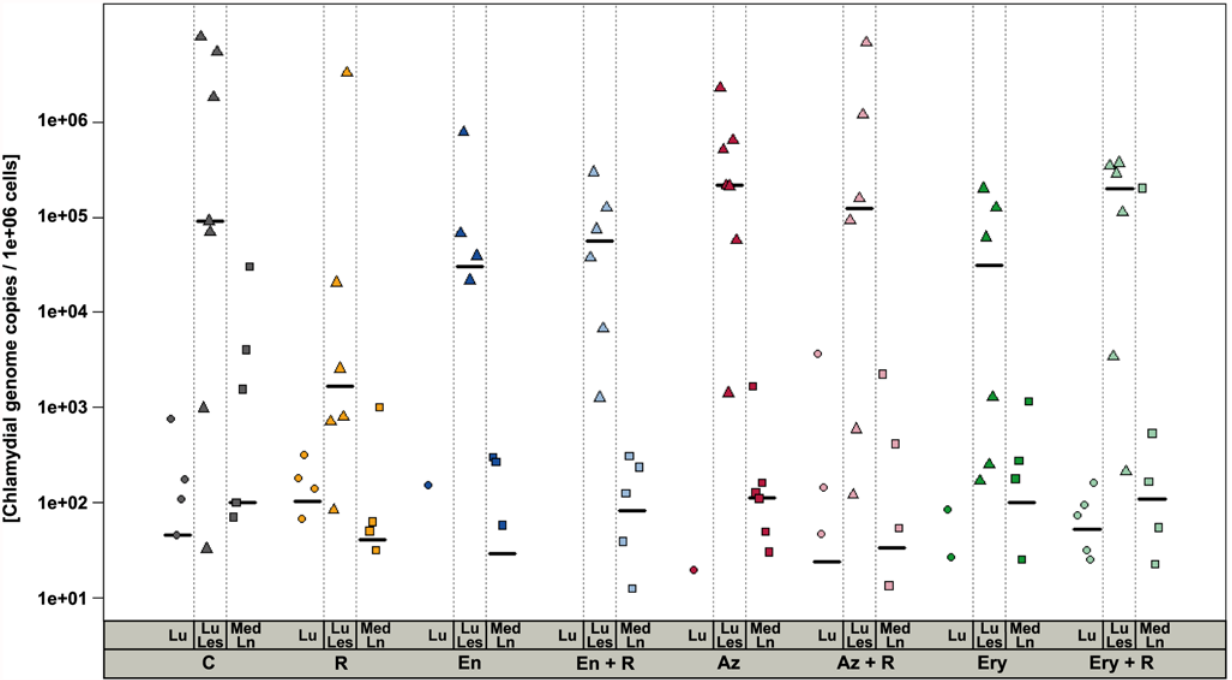
Fig 1. Chlamydial genome copies in tissue 14 days after inoculation. The number of chlamydial genome copies per one million cells determined with qrtPCR was higher in altered lung tissue (Lu Les, triangles) than it was in macroscopically normal lung tissue (Lu, circles) and in mediastinal lymph node (Med Ln, squares). Chlamydial DNA was detected in altered lung tissue of all animals except for two enrofloxacin-treated animals, whereas in some animals of all treatment groups no chlamydial DNA was detected in normal lung tissue and in the mediastinal lymph node. There was a high degree of variation in chlamydial genome copy numbers within the treatment groups and no statistically significant differences between treated and untreated groups for the amount of chlamydial DNA in the tissues sampled 14 dpi (many-to-one comparisons by Gao et al . (2008) with Hochberg-adjustment, P > 0.25). Black lines: medians, C: untreated controls, R: rifampicin, En: enrofloxacin, En + R: enrofloxacin + rifampicin, Az: azithromycin, Az + R: azithromycin + rifampicin, Ery: erythromycin, Ery + R: erythromycin + rifampicin. dpi: days post inoculation.